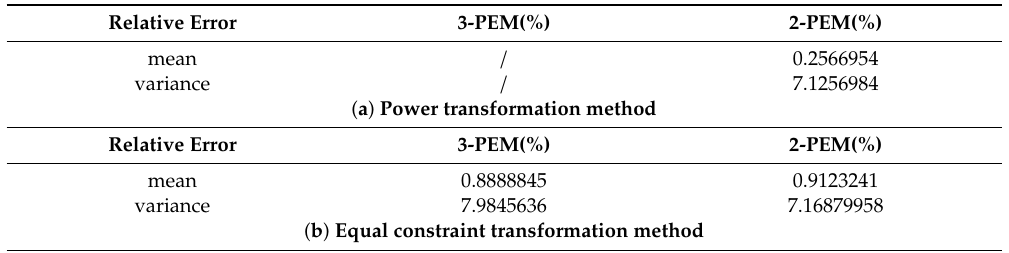
Table 8. Average relative error of power network after constraining estimation